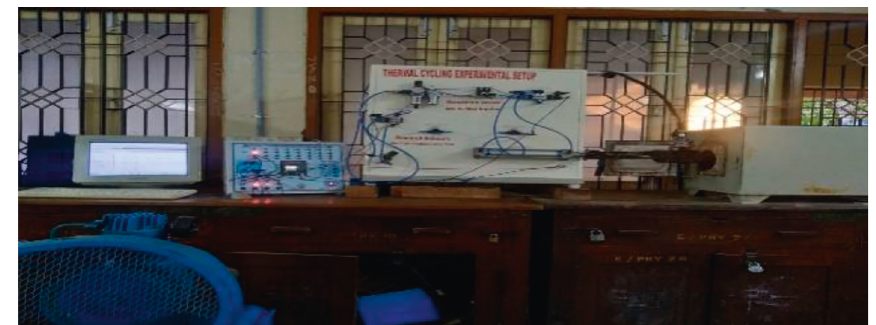
Figure 5: Thermal-cycled experimental setup.